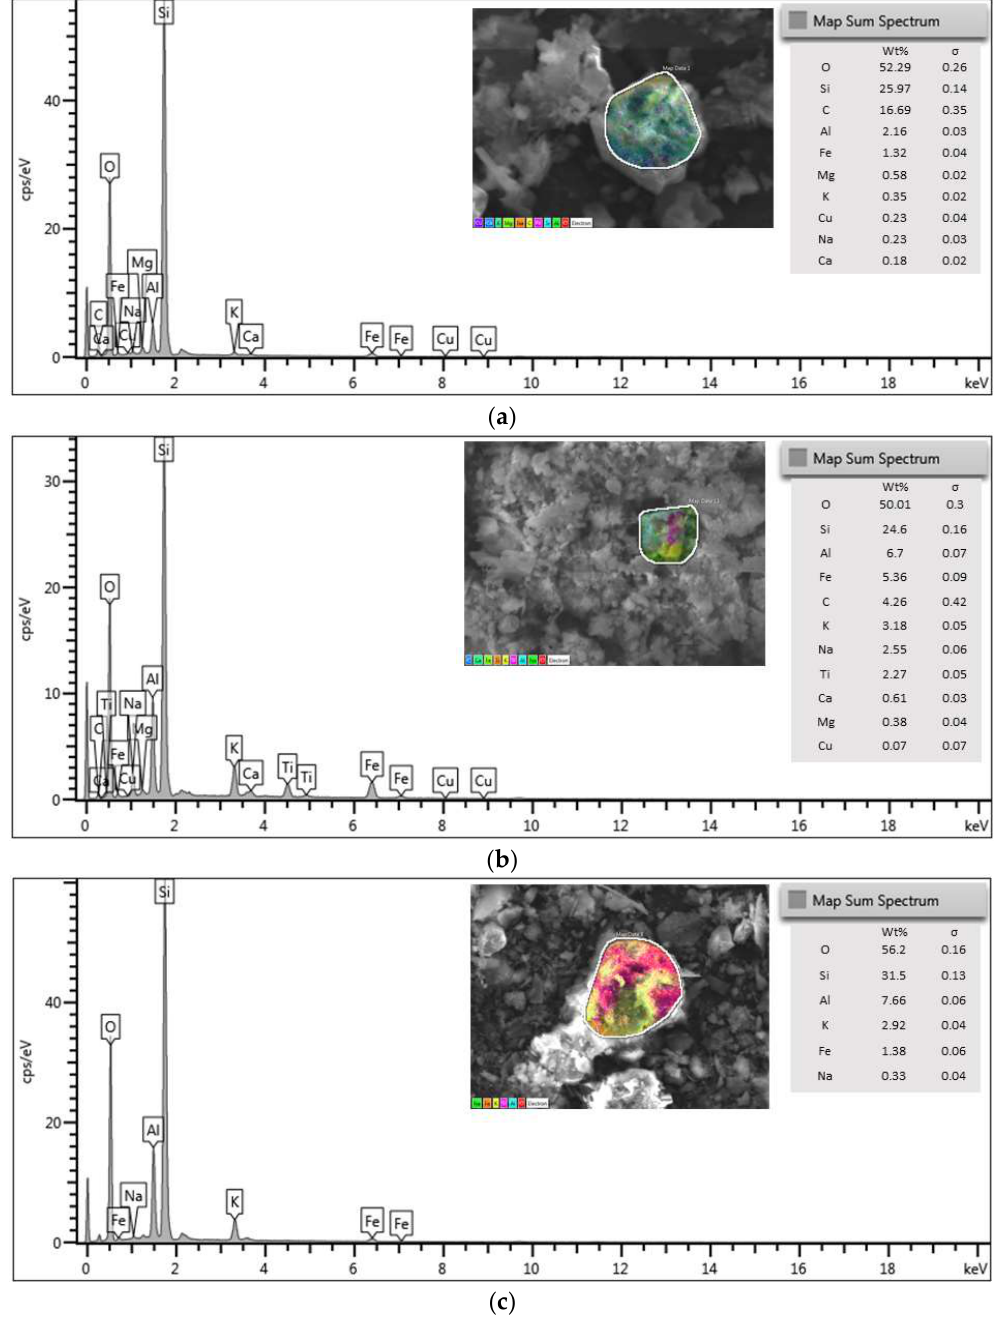
Figure 5. Energy-dispersive X-ray spectra of suspended solids obtained from ( a ) San Francisco River before confluence; ( b ) Yerba Loca Creek and ( c ) San Francisco River after confluence. C, O, Si, and Al are the main elements identified in the samples.